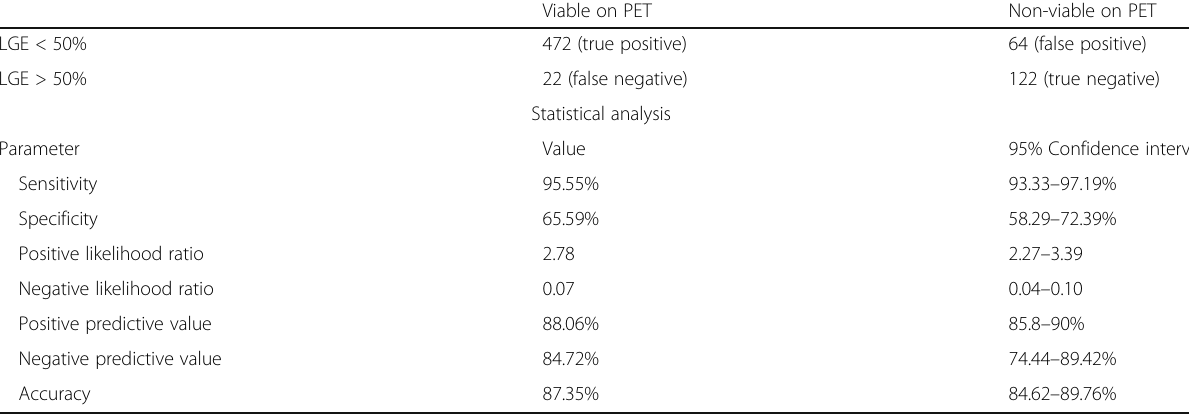
Table 1 Myocardial segment wise viability